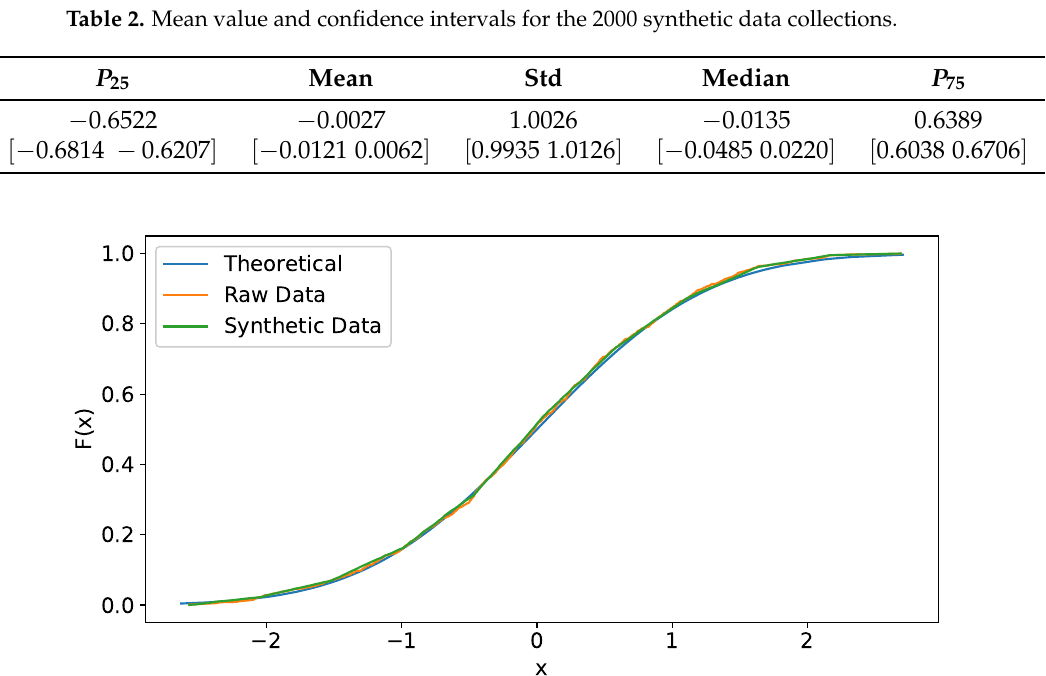
Figure 2. Theoretical distribution and empirical distribution of raw data and synthetic data.